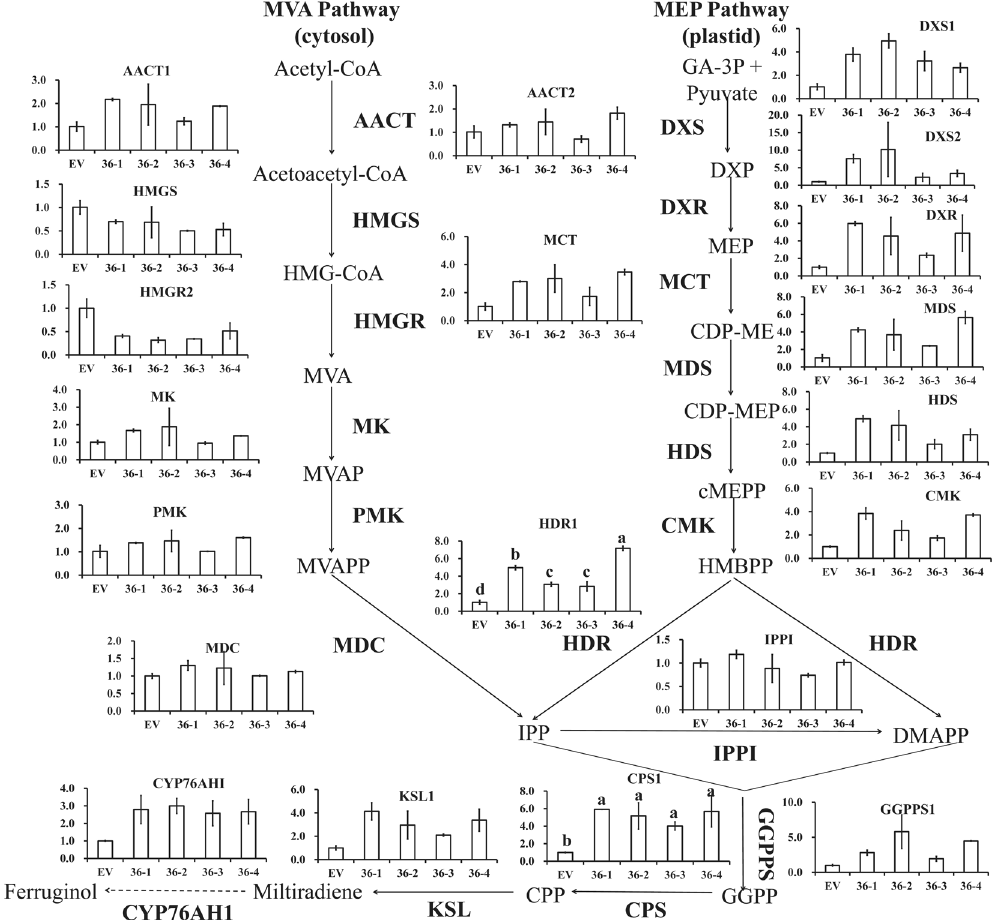
Figure 7. Relative expression level of tanshinone biosynthesis pathway genes in transgenic hairy roots. Each line has two biological repeats and each biological repeat has three technological repeats. All values are expressed as means ±